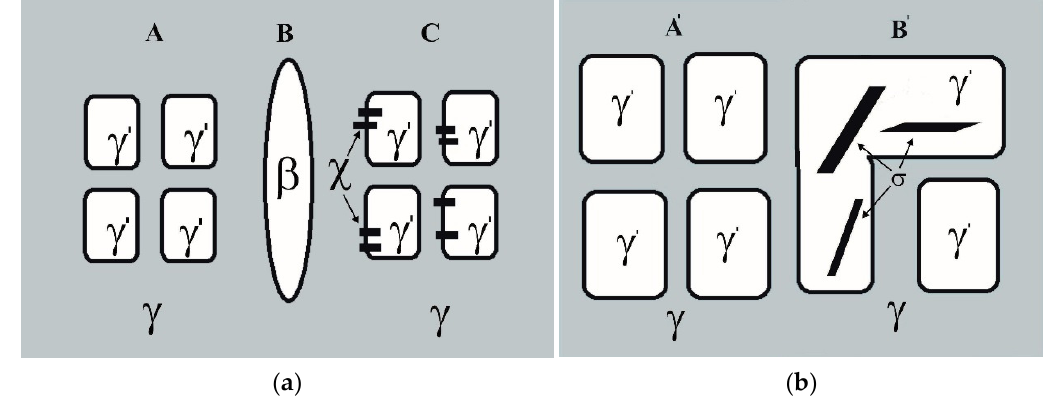
Figure 1. Schematic representation of the structure of the alloy: ( a ) the structure of the alloy in the initial state (after directional crystallization (DC)); ( b ) structure of the alloy after DC and annealing.